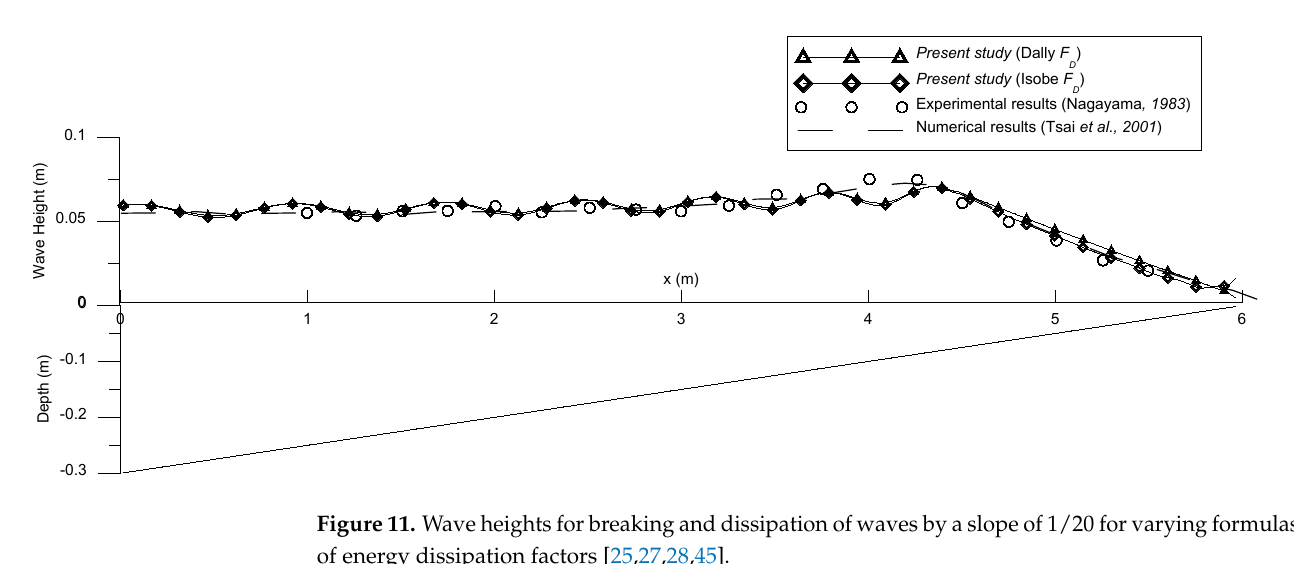
Figure 11. Wave heights for breaking and dissipation of waves by a slope of 1/20 for varying formulas of energy dissipation factors [25,27,28,45].